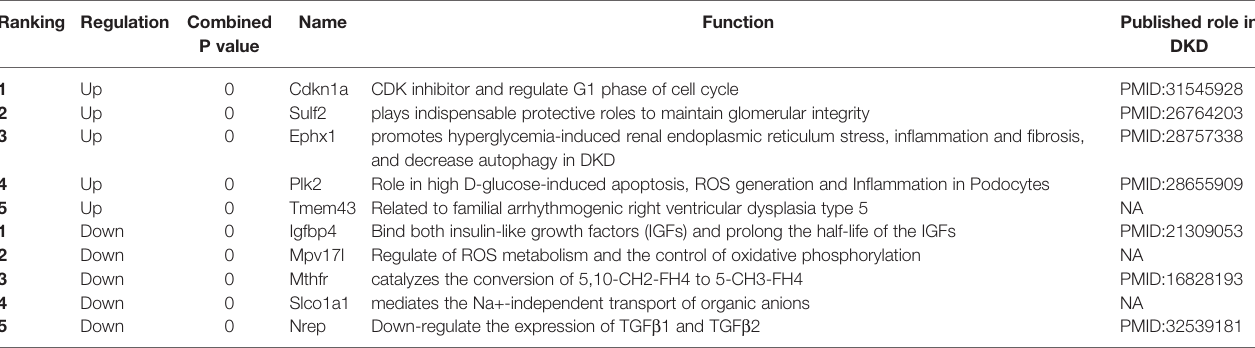
TABLE 2 | Shared DEGs found in